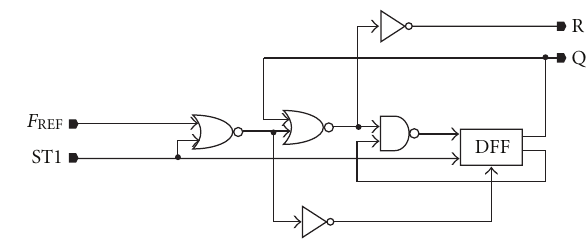
Figure 8: Block diagram of shot pulse